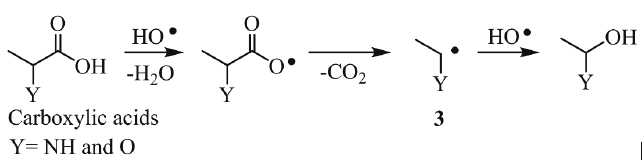
Figure 11. Neighboring hetero-atom assistance to the decarboxylation with HO •